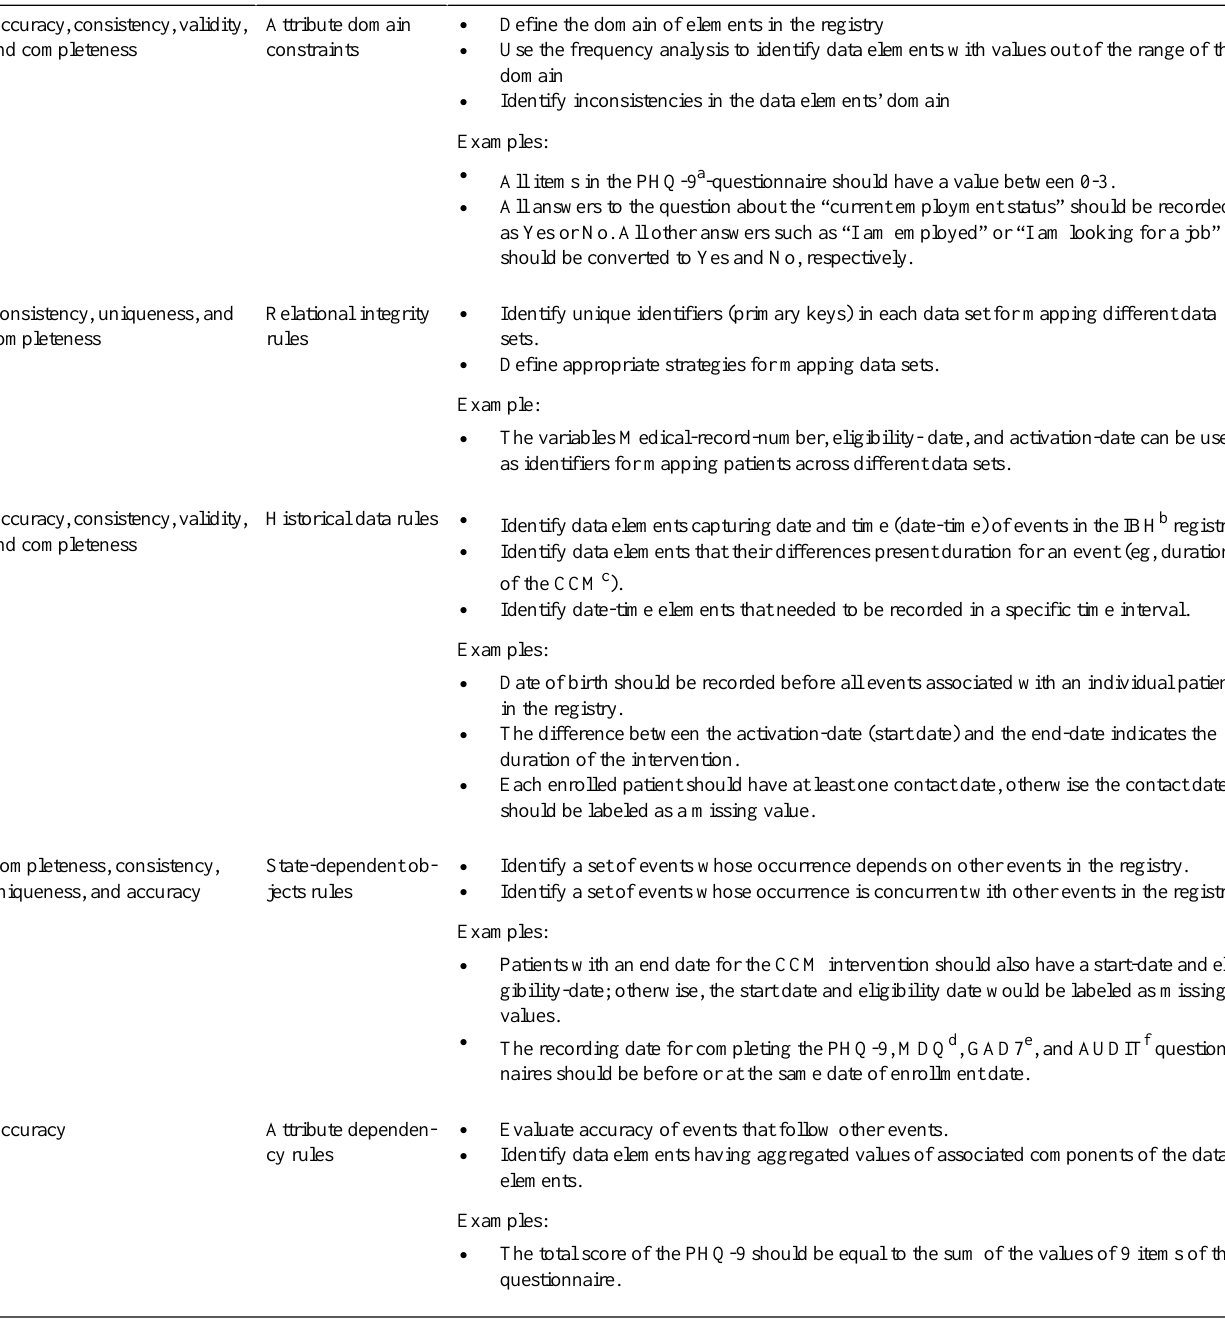
Generated rules with examplesComponentsDimensions of data